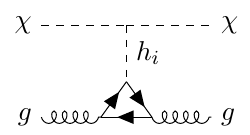
Figure 1 . Interaction of a DM particle and a gluon via a Higgs boson mediator and a quark loop.